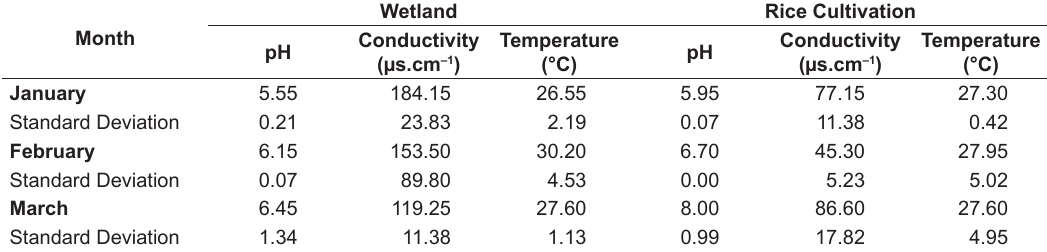
Table 1. Abiotic water parameter analyzed during the collection